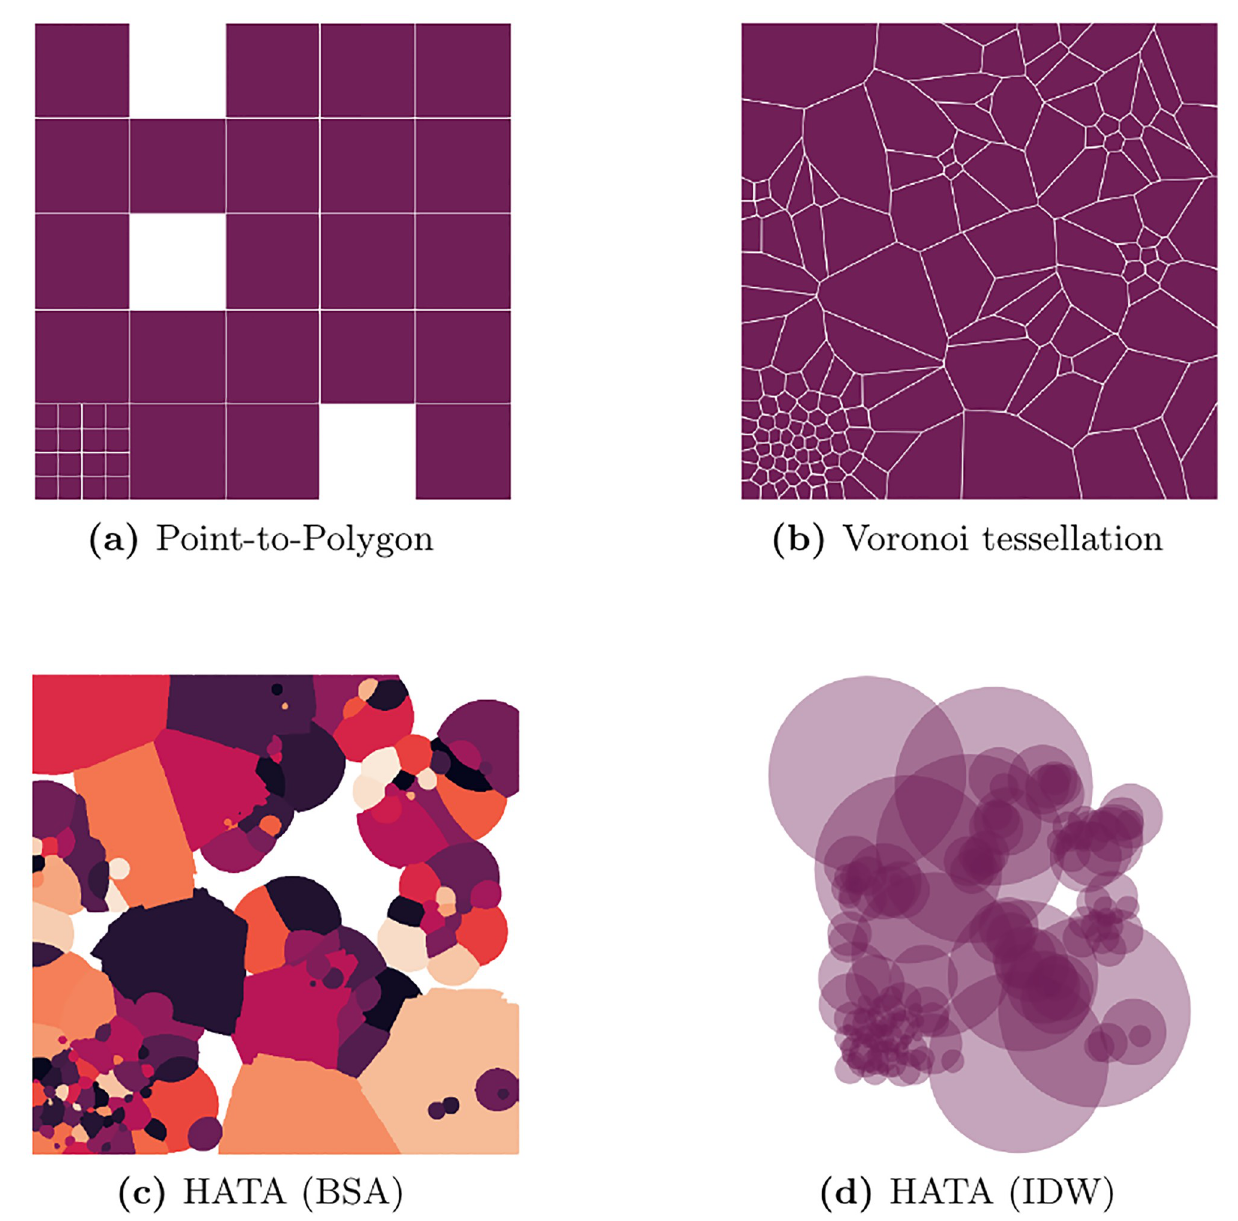
Fig 6. Coverage areas